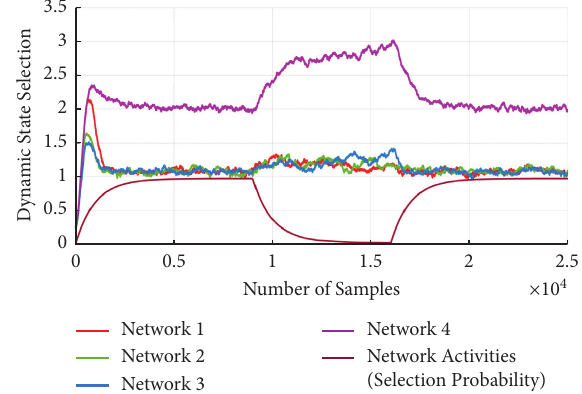
Figure 16: Effect of threshold on network connectivity for threshold � 2 ( S l � 3).